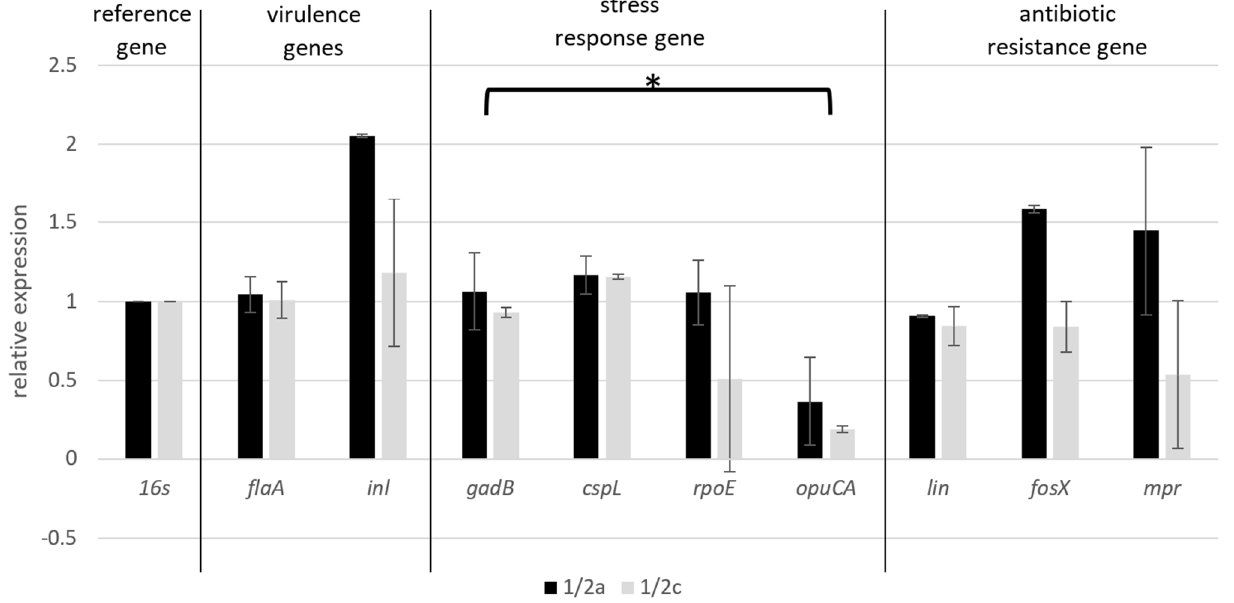
Figure 5. Relative expression of selected L. monocytogenes strains, *— p = 0.0393.